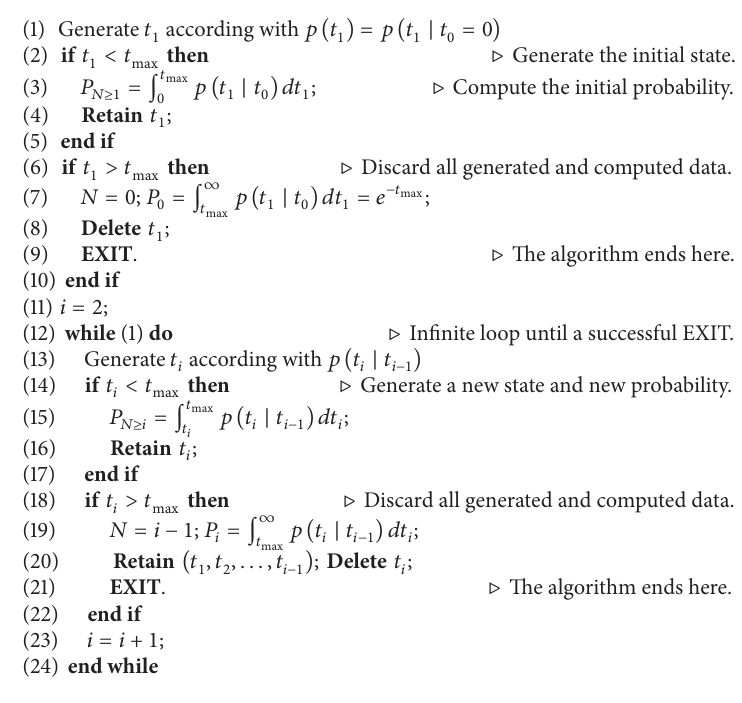
Algorithm 3: 1-Dimensional Monte Carlo Markovian Algorithm.